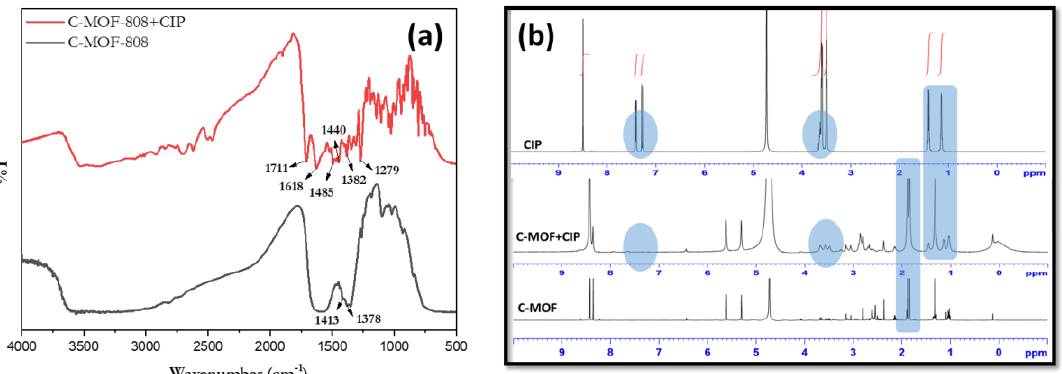
Figure 9. ( a ) FTIR spectra of the receptor (C-MOF-808) and the analyte (CIP) and ( b ) 1 H-NMR spectra of receptor, CIP, and receptor with CIP in D 2 O.